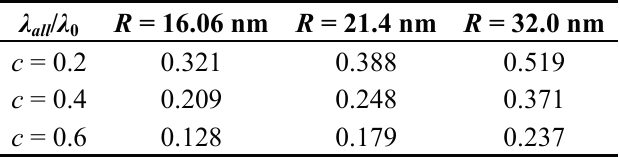
Table 1. Ratio of our simulations results λ molecular mean free path.